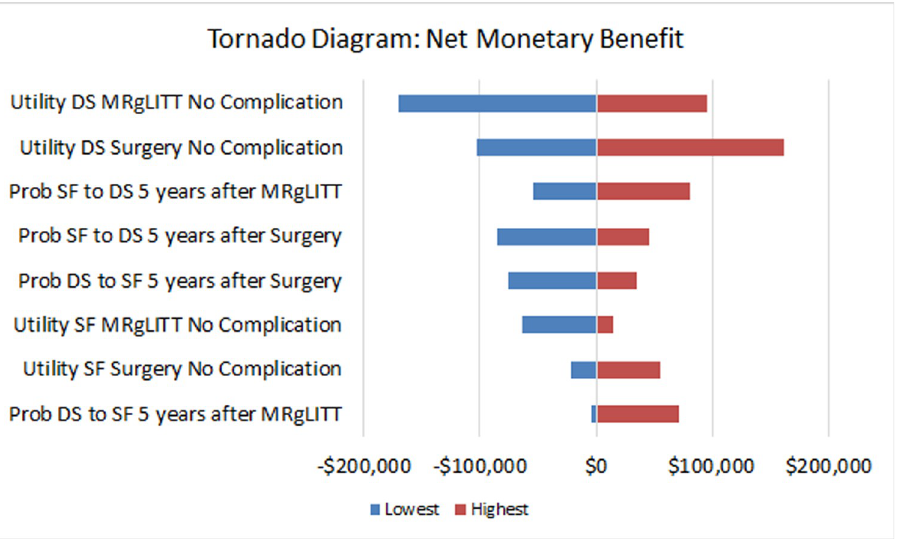
Fig 2. Tornado diagram from one-way sensitivity analyses showing the incremental net monetary benefit (NMB) of MRgLITT versus surgery. Influential parameters include utility of disabling seizures state after MRgLITT as well as surgery and without complication, probability of returning to disabling seizures from seizure-free state 5 years after surgery as well as MRgLITT, probability of becoming seizure-free from disabling seizures state 5 years after surgery as well as MRgLITT, and utility of seizure-free after surgery without complication. (SF: seizure-free; DS: disabling seizures).